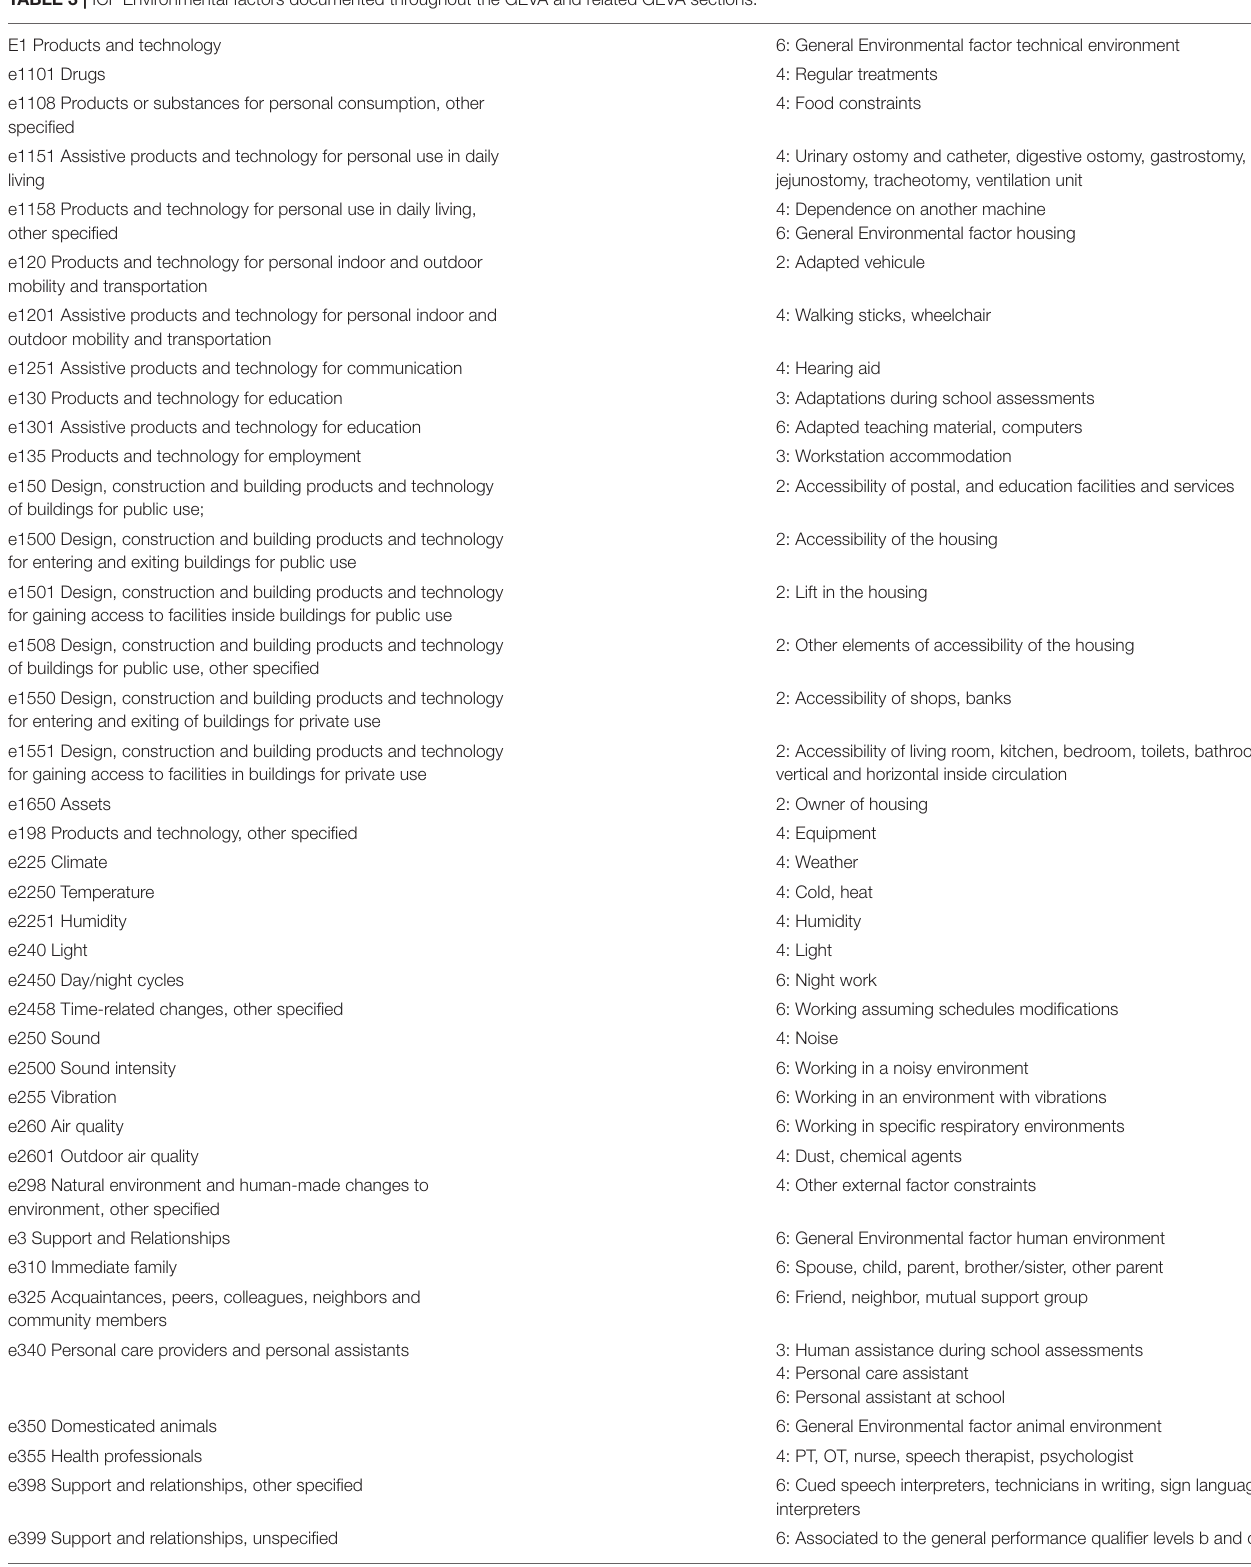
TABLE 3 | ICF Environmental factors documented throughout the GEVA and related GEVA